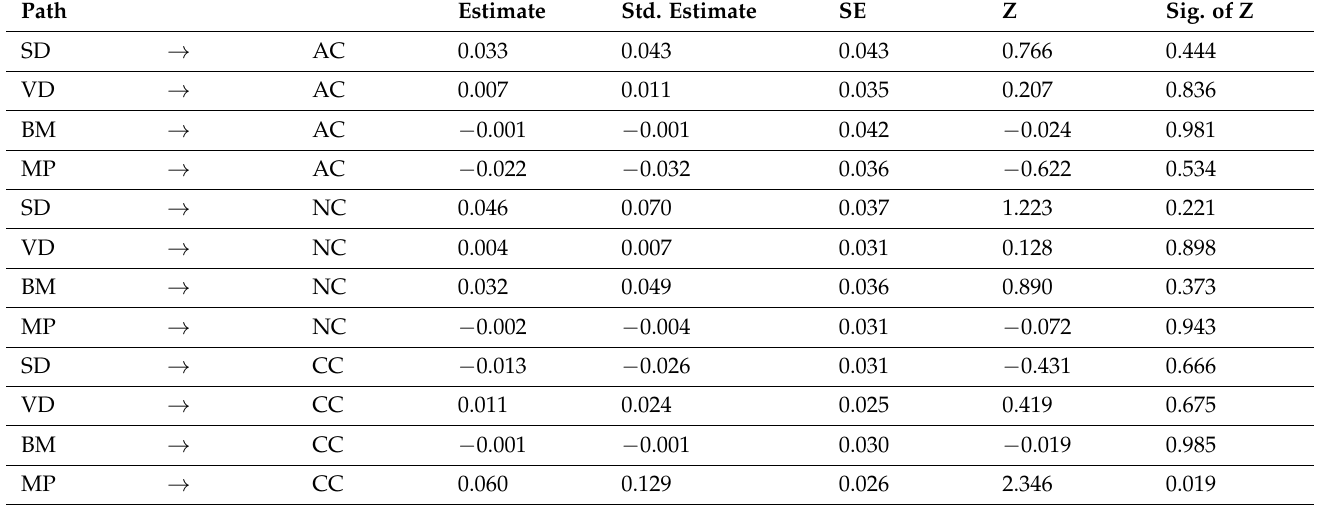
Table 7. Fit Indexes for the Structural